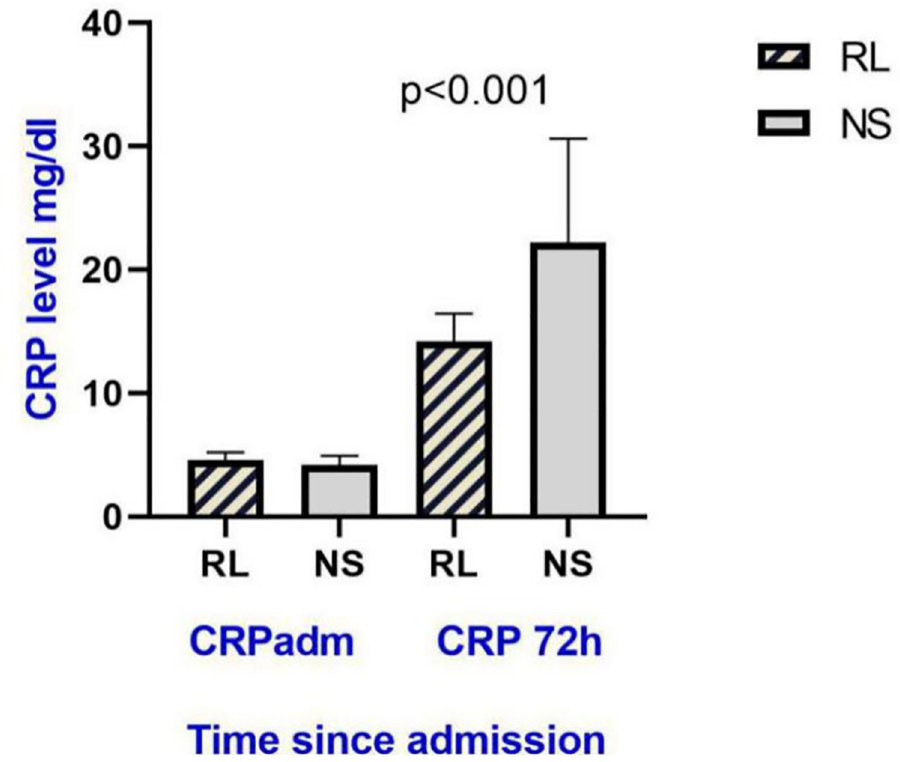
Fig 4. Bar diagram showing the CRP titre and its increment at 72 hours from the baseline values in the study population. CRP adm: CRP level at admission, CRP 72h: CRP lever after 72 hours of admission, RL: Ringers lactate, NS: Normal Saline.